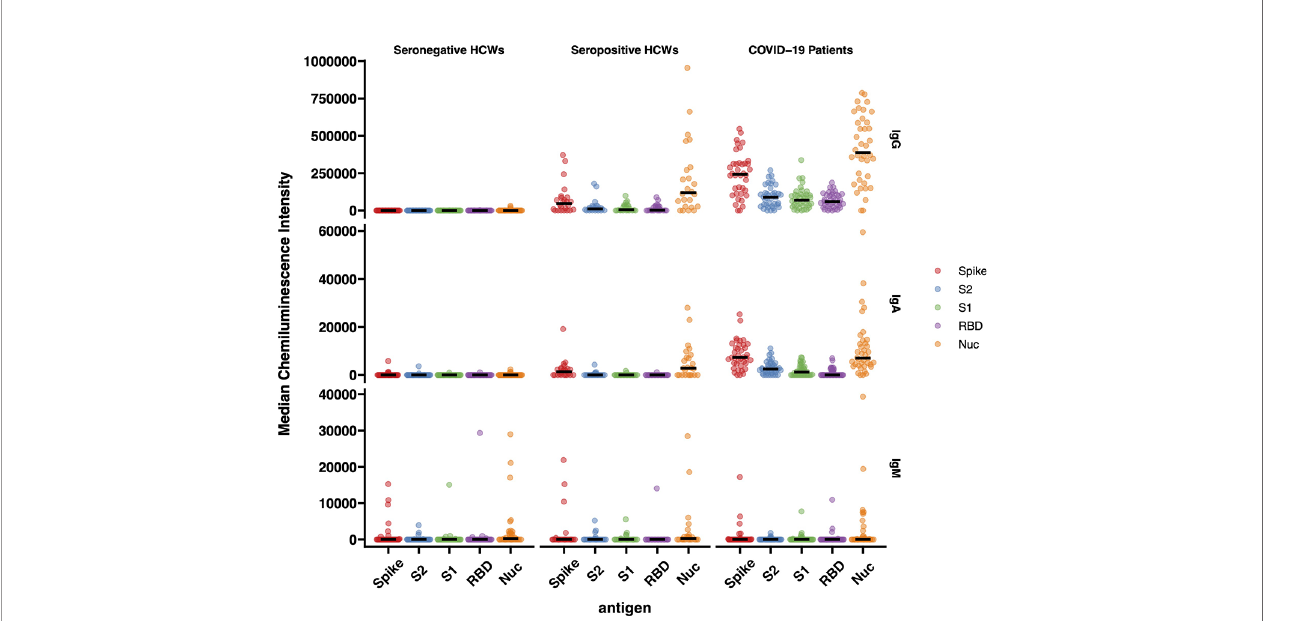
FIGURE 4 | IgG, IgA and IgM responses against Spike, RBD, S1, S2 and N antigens of SARS-CoV-2. The image displays the Median Chemiluminescence Intensities of antigen-speci fi c IgG (top), IgA (middle) and IgM (bottom) of seronegative HCWs (left), seropositive HCWs (middle) and COVID-19 patients (right). A panel of pre-pandemic sera was used to calculate the negative cut-off value for each antigen (mean + 2STD) and then subtracted from the chemiluminescent signal of each